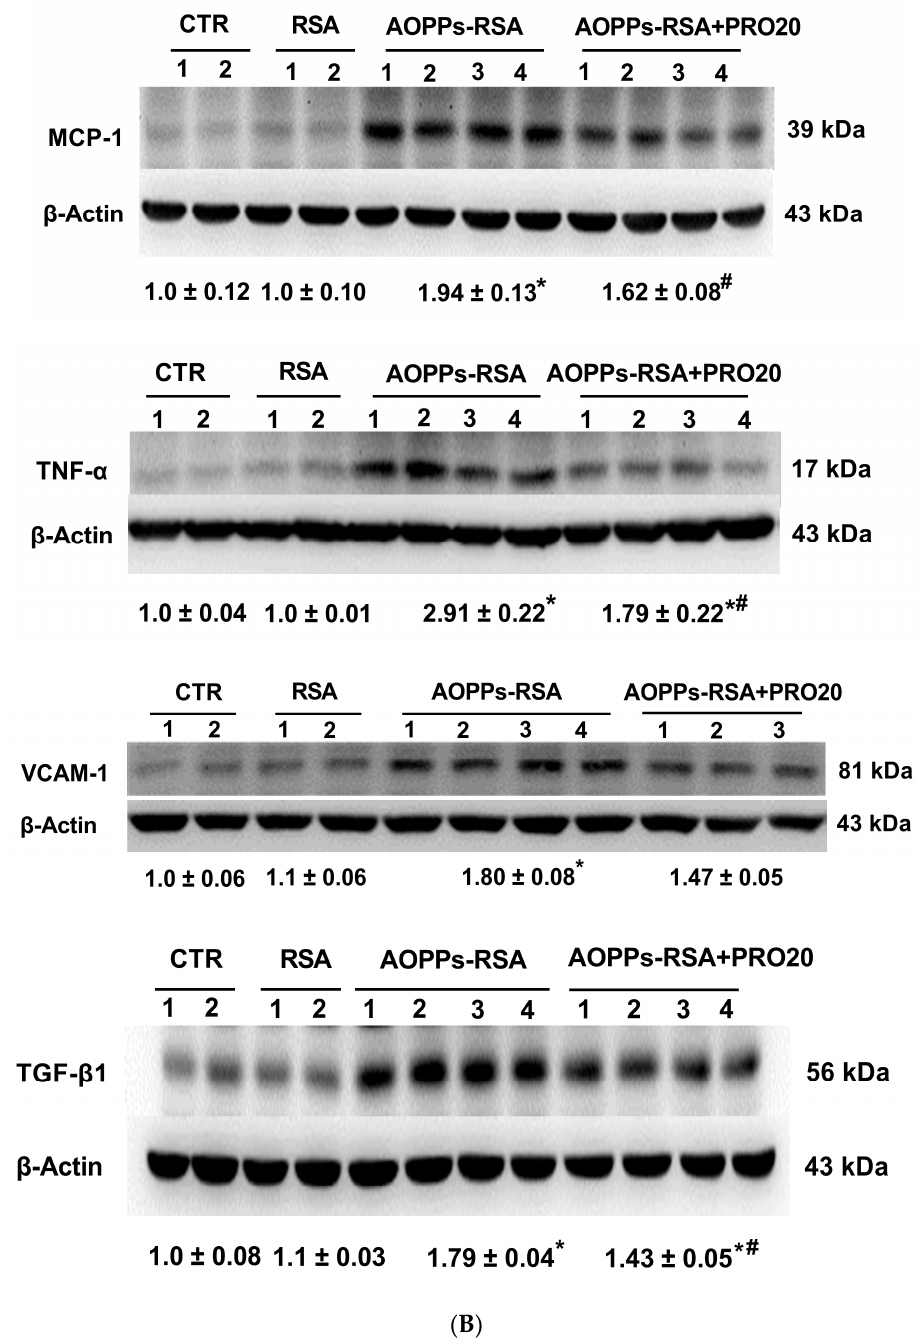
Figure 3. Administration of PRO20 reduced renal pro-inflammatory and fibrosis mediator secretion induced by AOPPs-RSA. Notes: ( A ) The mRNA expression levels of MCP-1, TNF- α , VCAM-1, and TGF- β 1 in renal tissue were checked by RT-qPCR. All values were normalized against GAPDH expressions. ( B ) The protein levels of MCP-1, TNF- α , VCAM-1, and TGF- β 1 were determined by immunoblotting analysis. The normalized quantitative data for β -actin are shown below each blot. All data are presented as mean ± SEM. There were 6 rats per group. * p < 0.05, compared to the CTR group; # p < 0.05, compared to AOPPs-RSA group. MCP-1, monocyte chemotactic protein-1; TNF- α , tumor necrosis factor- α ; VCAM-1, vascular cell adhesion molecule-1; TGF- β 1, transforming growth factor- β 1.